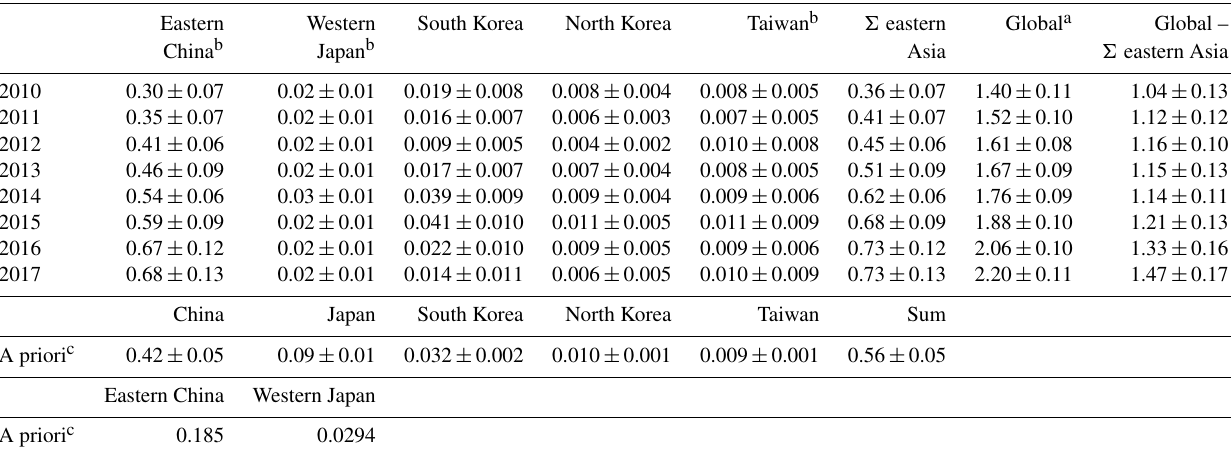
Table 2. Regional c -C 4 F 8 emissions derived for eastern Asia from Gosan measurements (NAME-HB inversion) and comparison to global emissions (Ggyr − 1 , ktyr − 1